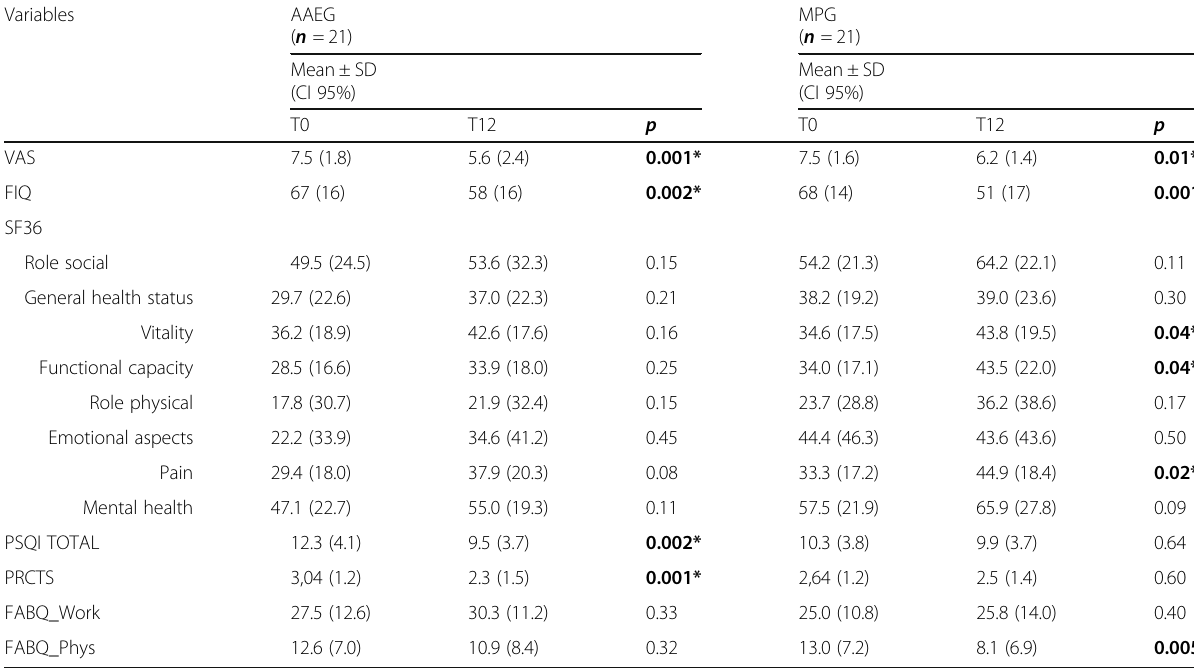
Table 2 Mean values and standard deviation (SD) of the analyzed variables in the two evaluation moments (T0 and T12) in the two evaluated